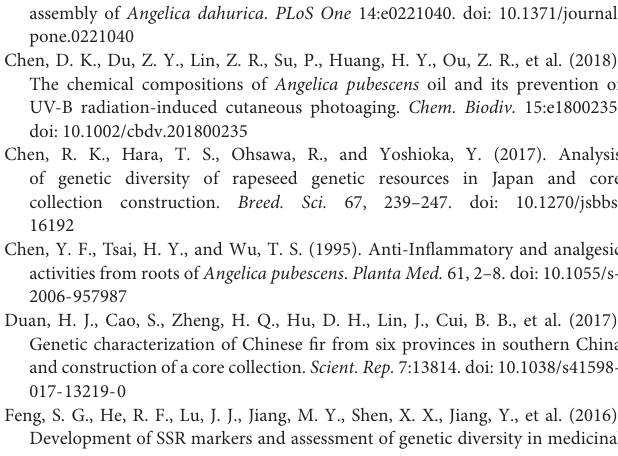
Supplementary Table 1 | The specific geographical information of 3 sampling positions of wild A. biserrata. Supplementary Table 2 | Transcriptome sequencing data quality and splicing results statistics of A. biserrata . Supplementary Table 3 | Distribution of simple sequence repeats (SSRs) in A. biserrata transcription. Supplementary Table 4 | Distribution characteristics of different EST-SSR types in transcriptions of A. biserrata . Supplementary Table 5 | Distribution characteristics of the different EST-SSRs repeat times observed in the A. biserrata . Supplementary Table 6 | Types and Quantities of mononucleotide to trinucleotide EST-SSR repeat motifs in EST-SSR of A.biserrata . Supplementary Table 7 | Primer sequence information of 17 pairs of SSR primers.